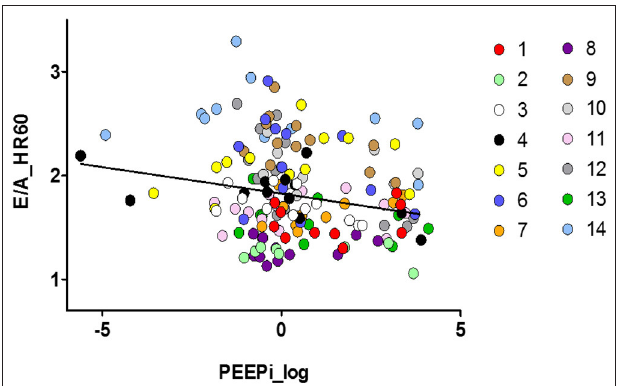
FIGURE 3 | Scatter plot of the association between left ventricular diastolic function and dynamic hyperinflation of the lungs. Individual observations (1–14) are color coded. E/A_HR60, ratio of transmitral E- to A-wave corrected for a heart rate of 60/min; PEEPi log, log transformed intrinsic positive end-expiratory pressure (cmH2O).